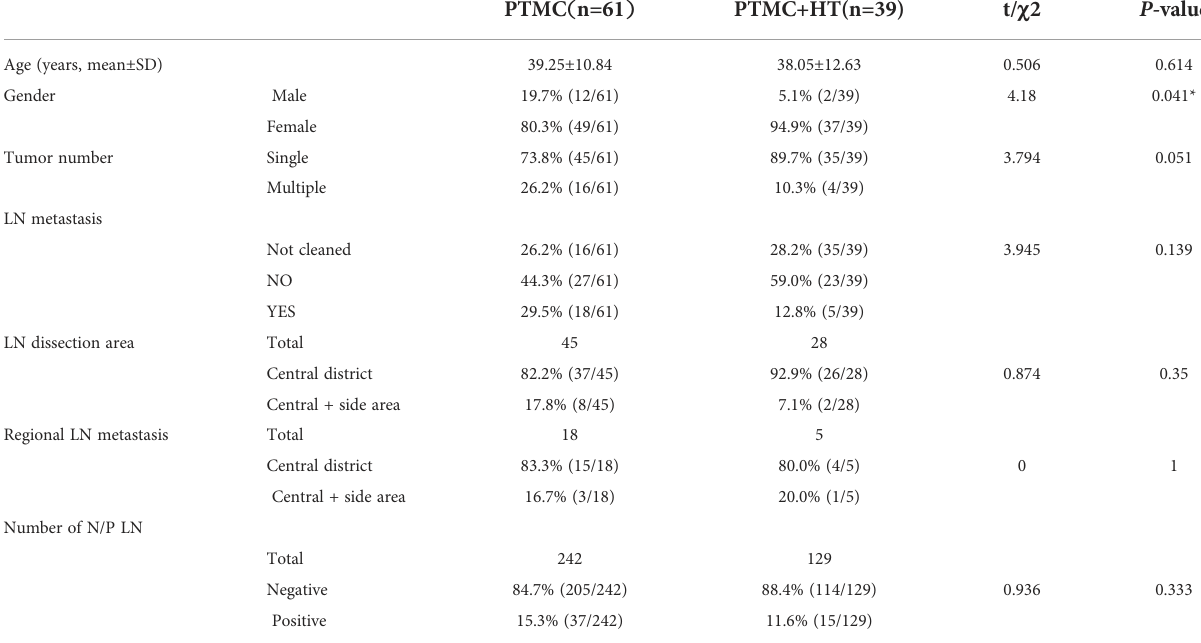
TABLE 5 Patient Characteristics of PTMC and PTMC with